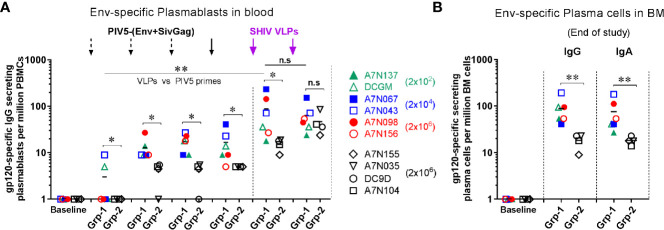
Induction of antigen-specific plasmablast responses in peripheral blood and long-lived plasma cells in bone marrow from both groups. Comparison of Env-specific (A) plasmablast responses at day 5 after each immunization, and (B) plasma cells responses in BM at the end of study between Group 1 (Grp-1, Week 81) and Group 2 (Grp-2, Week 71). One-way ANOVA test was used to compare the 1st VLPs boost to the all PIV5 primes differences among 5 groups. Three black dashed arrows mark PIV5-(Env+SivGag) primes with different doses (IN) and one black solid arrow marks the fourth prime. Purple solid arrows mark the SHIV VLPs boosts (IM). The level of significance is indicated by P-values as follows: *P < 0.05; **P < 0.01. n.s, P > 0.05, not significant.